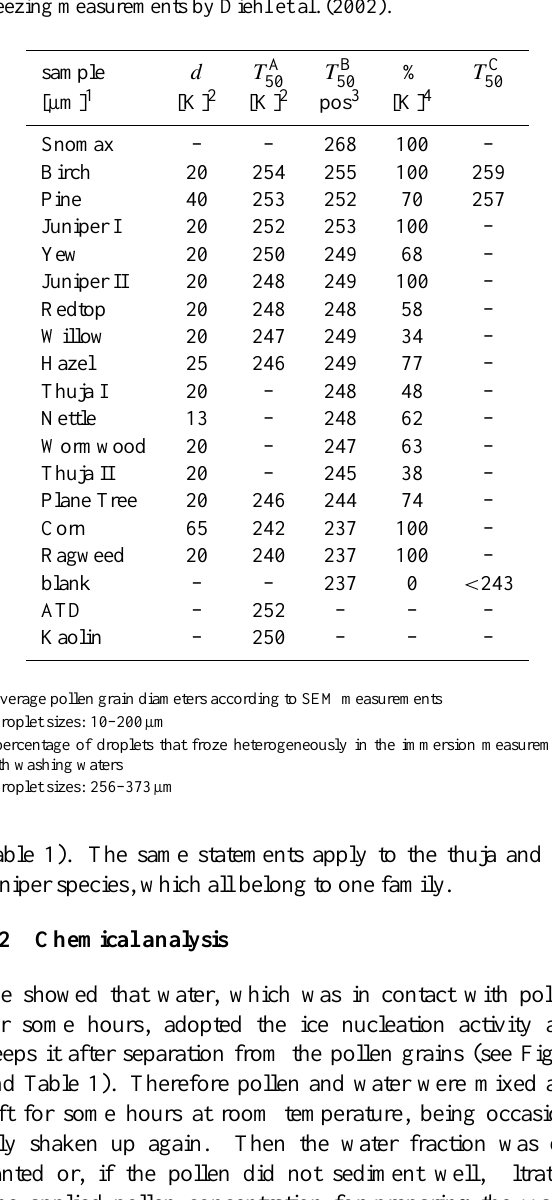
Table 1. Median freezing temperatures from the oil immersion mode and the flow tube measurements: T 50 stands for the tem- peratures, where 50% of all droplets are frozen (median freezing temperatures), with A for the whole pollen grains in oil immersion, B for the washing waters in oil immersion and C for immersion freezing measurements by Diehl et al.